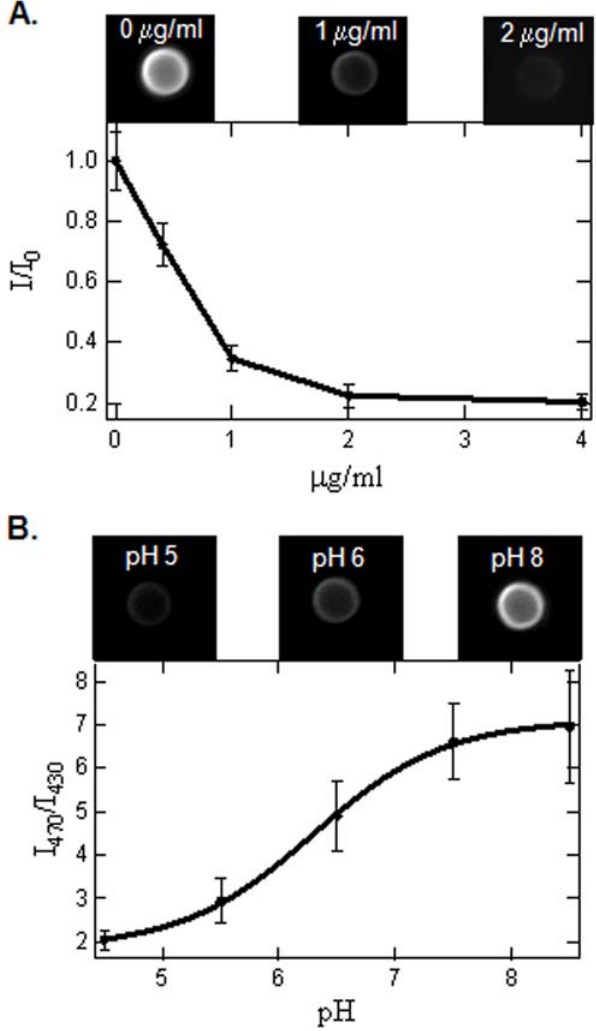
Alexa488 concentration. B.) Ratio of the fluorescence intensities of FITC/ InlA-beads at 430 and 470 nm excitation wavelengths across a range